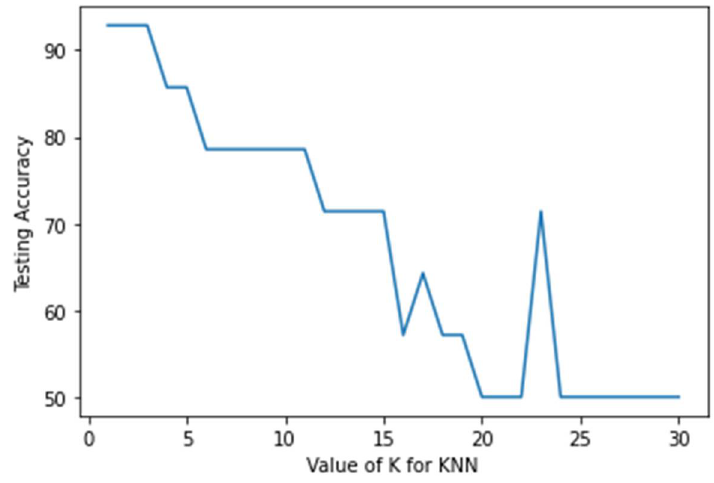
Figure 4. Variation of testing accuracy vs. value of K.